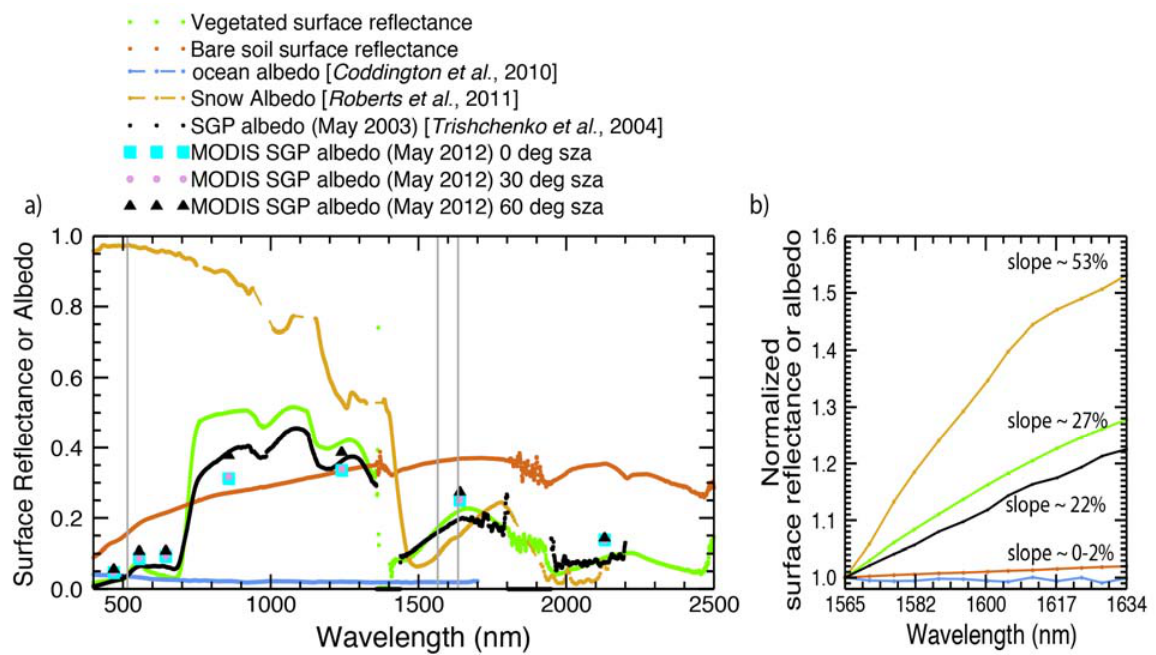
Figure 3. ( a ) Measured and retrieved spectral albedo and reflectance of common surface types from different geographic regions at different times. The data are from ground-based (vegetated and bare soil reflectances), airborne (ocean, snow, and vegetated Southern Great Plains (SGP) site in Oklahoma), and satellite measurements (vegetated SGP site; shown at three solar zenith angles—see text). Vertical grey lines denote the location of the 515 nm and 1,565 nm–1,634 nm retrieval wavelengths. ( b ) Spectral slopes of the albedo and reflectance between 1,565 nm and 1,634 nm, normalized by the respective albedo or reflectance at 1,565